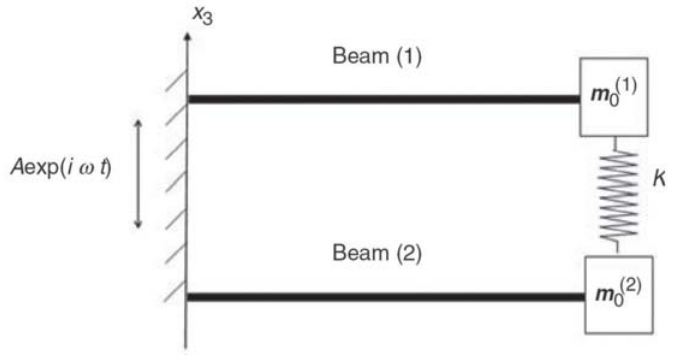
Figure 3. Two bimorphs spring connected analytic model.